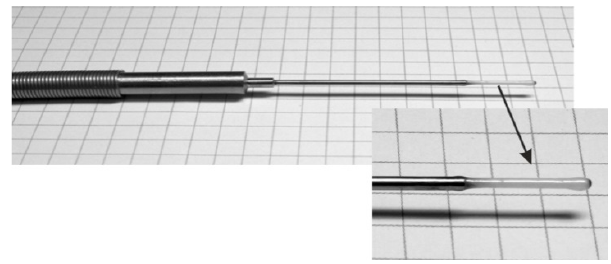
Figure 3. Special thermometer with an unshielded sensing element.